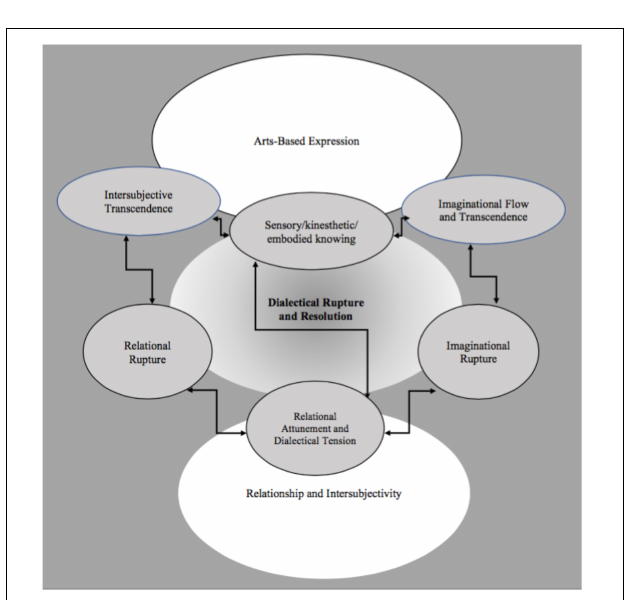
FIGURE 2 | Figure/ground system for dynamic change.